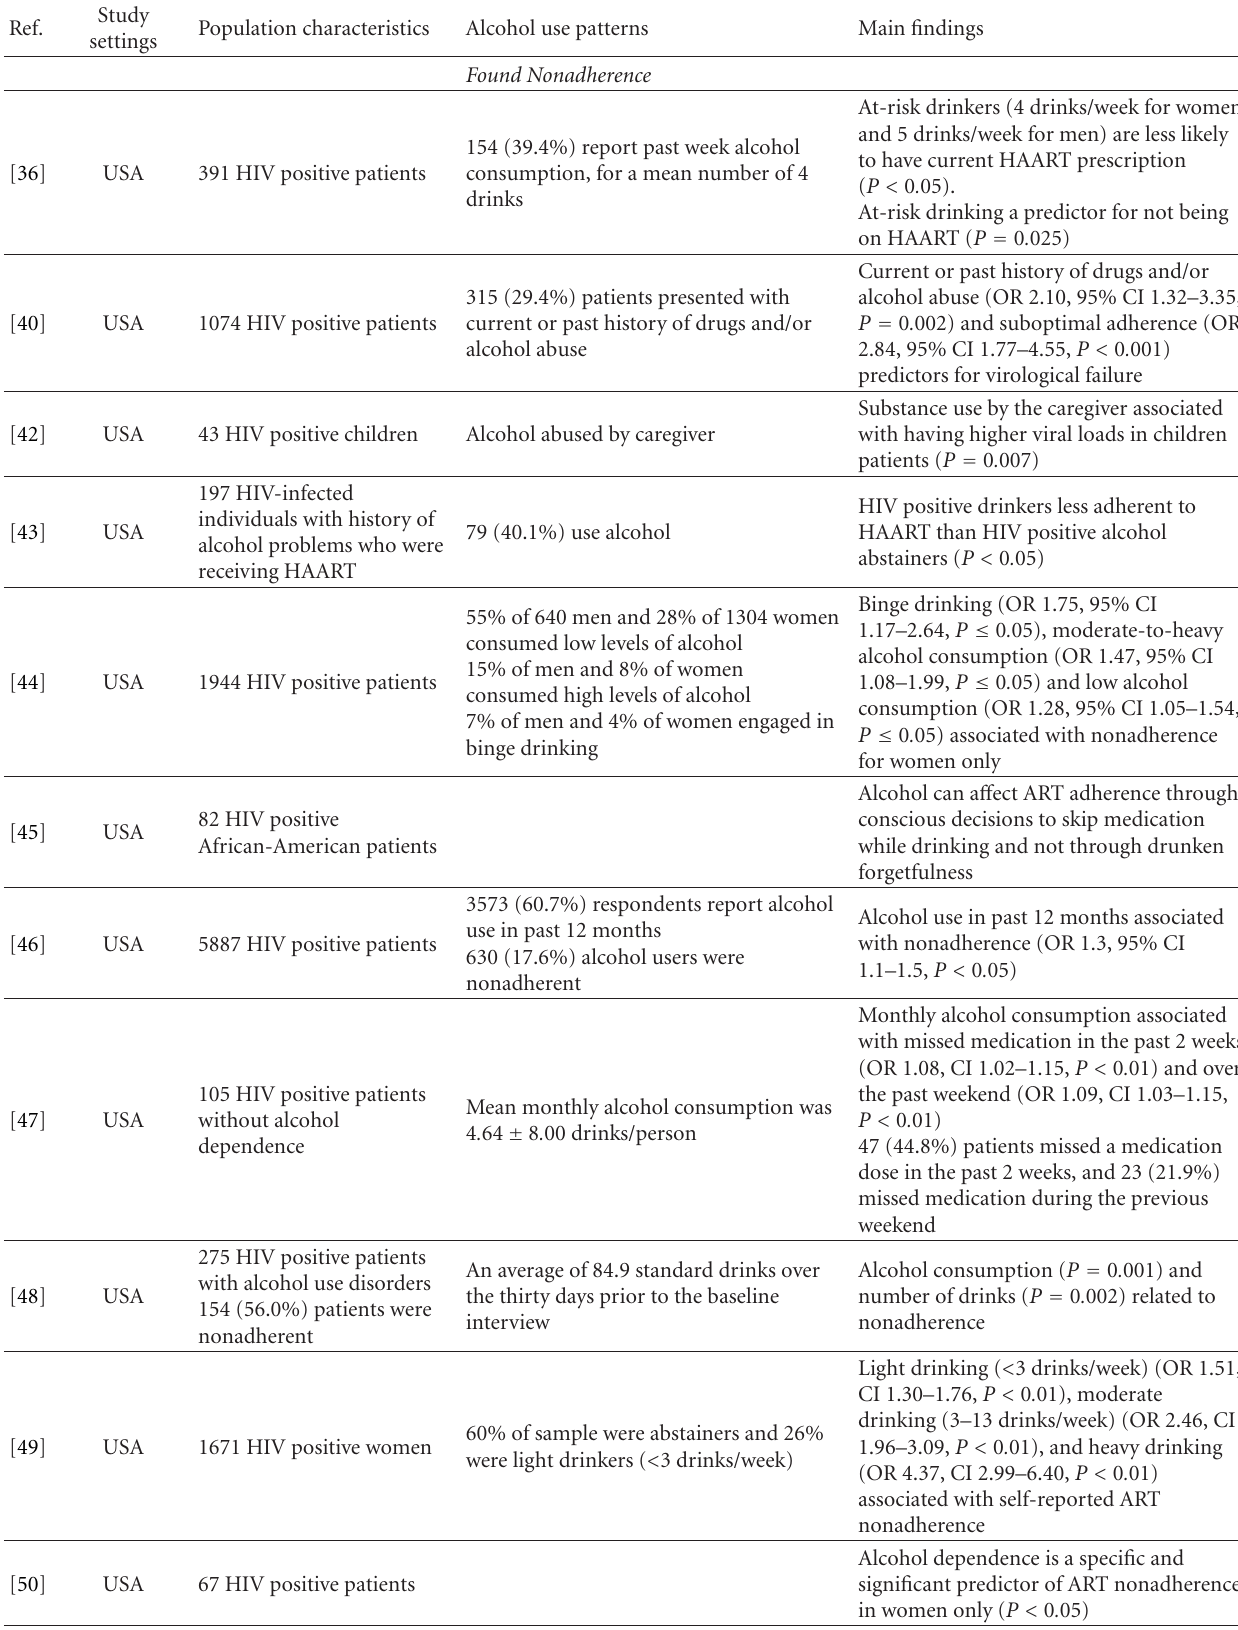
Table 3: Alcohol Consumption and Nonadherence to